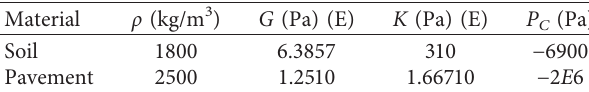
Table 4: Parameters of soil and concrete pavement.